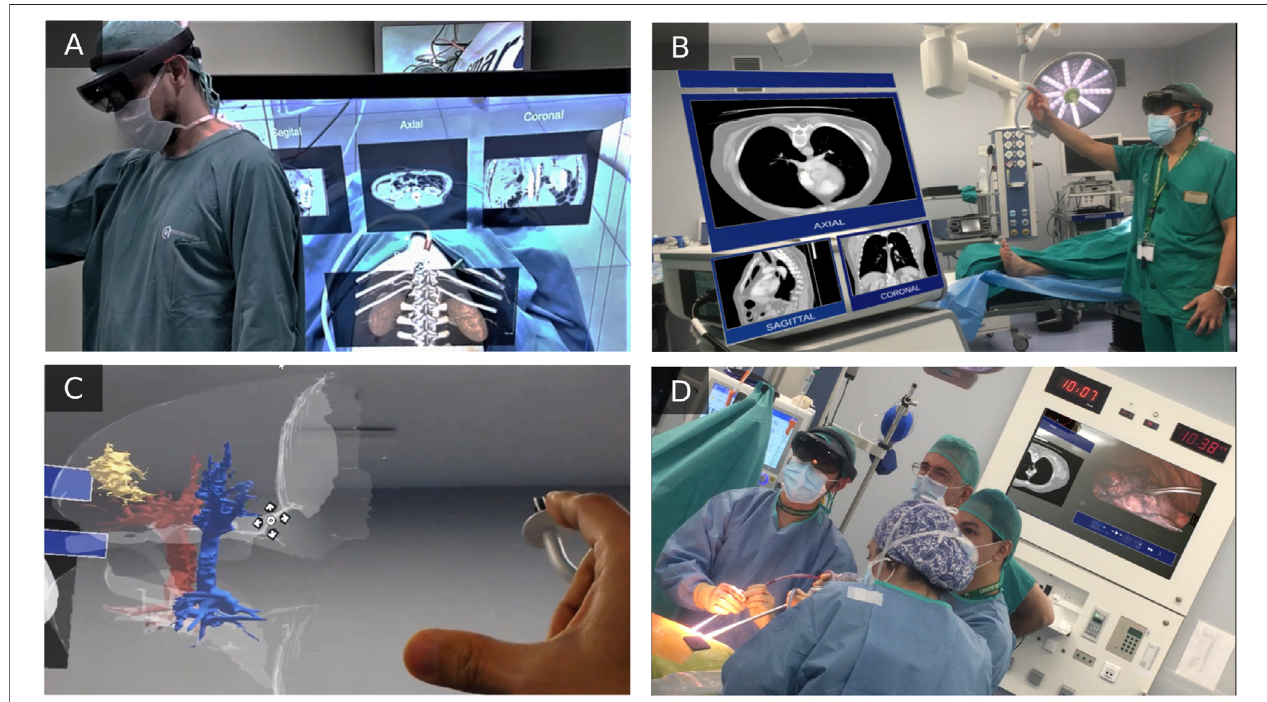
FIGURE 5 | (A) Interaction with preoperative study views and their corresponding 3D model for planning the renal tumorectomy in the porcine model. (B) Axial, coronal, and sagittal views of the preoperative study for planning the video-assisted lobectomy. (C) Interaction with the patient ’ s anatomical 3D model with information on the vascular structures and the tumor to be addressed during the surgical procedure. The surgeon placed the model according to the patient ’ s position (D) An additional screen shared the surgical planning assistance contents with the rest of the surgical team, such as the CT study and a reference video of the surgical procedure to be